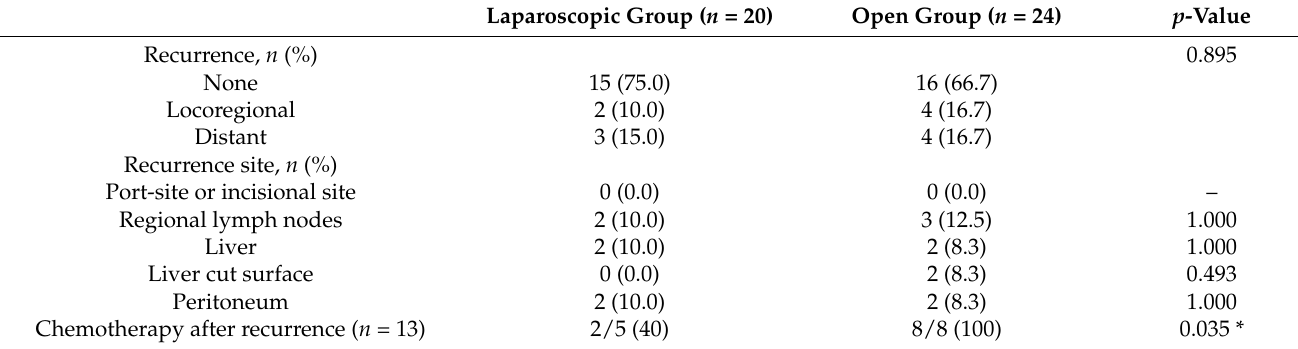
Table 4. Details of disease recurrence and